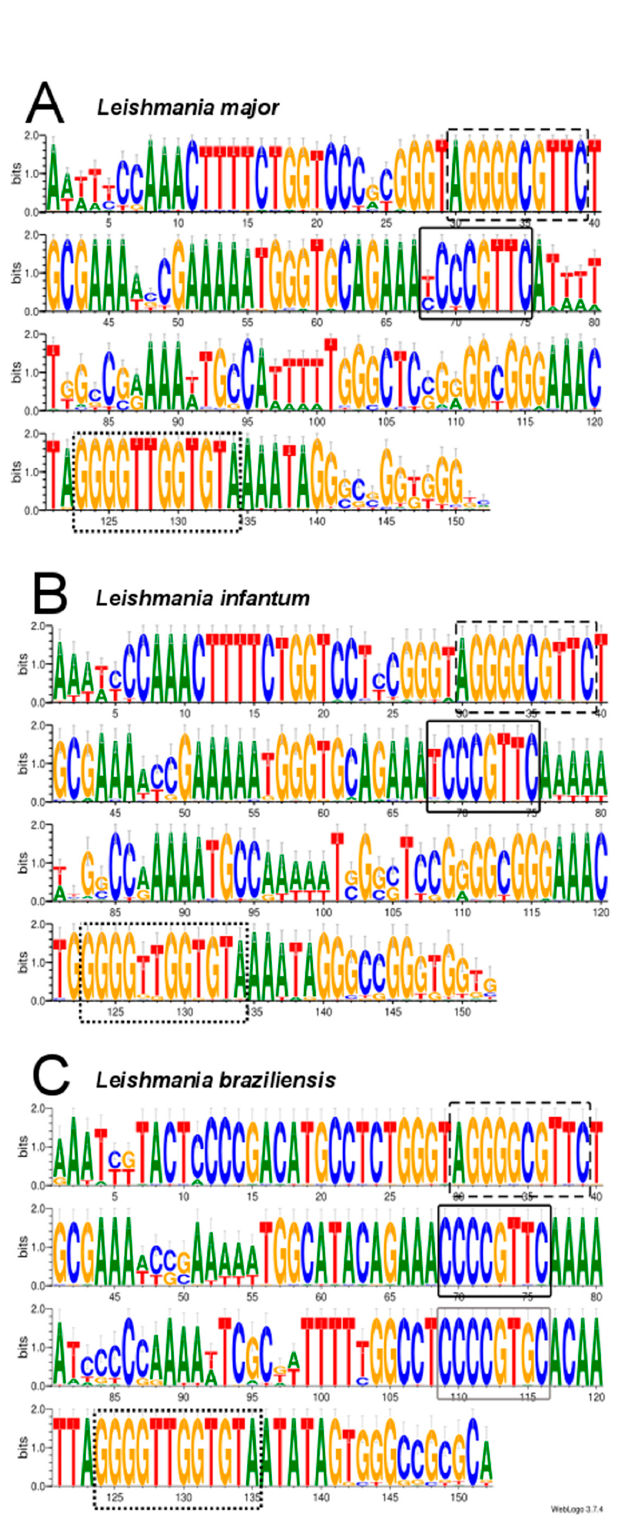
Figure 3. Sequence conservation analysis among the di ff erent minicircles assembled for L. major ( A ), L. infantum ( B ) and L. braziliensis ( C ). Images were generated using the WebLogo 3 server [41]. The conserved motifs CSB1 (dashed-black box), CSB2 (black box) and CSB3 (dotted-black box) are highlighted. In the L. braziliensis sequence, a CSB-2 like sequence is boxed in